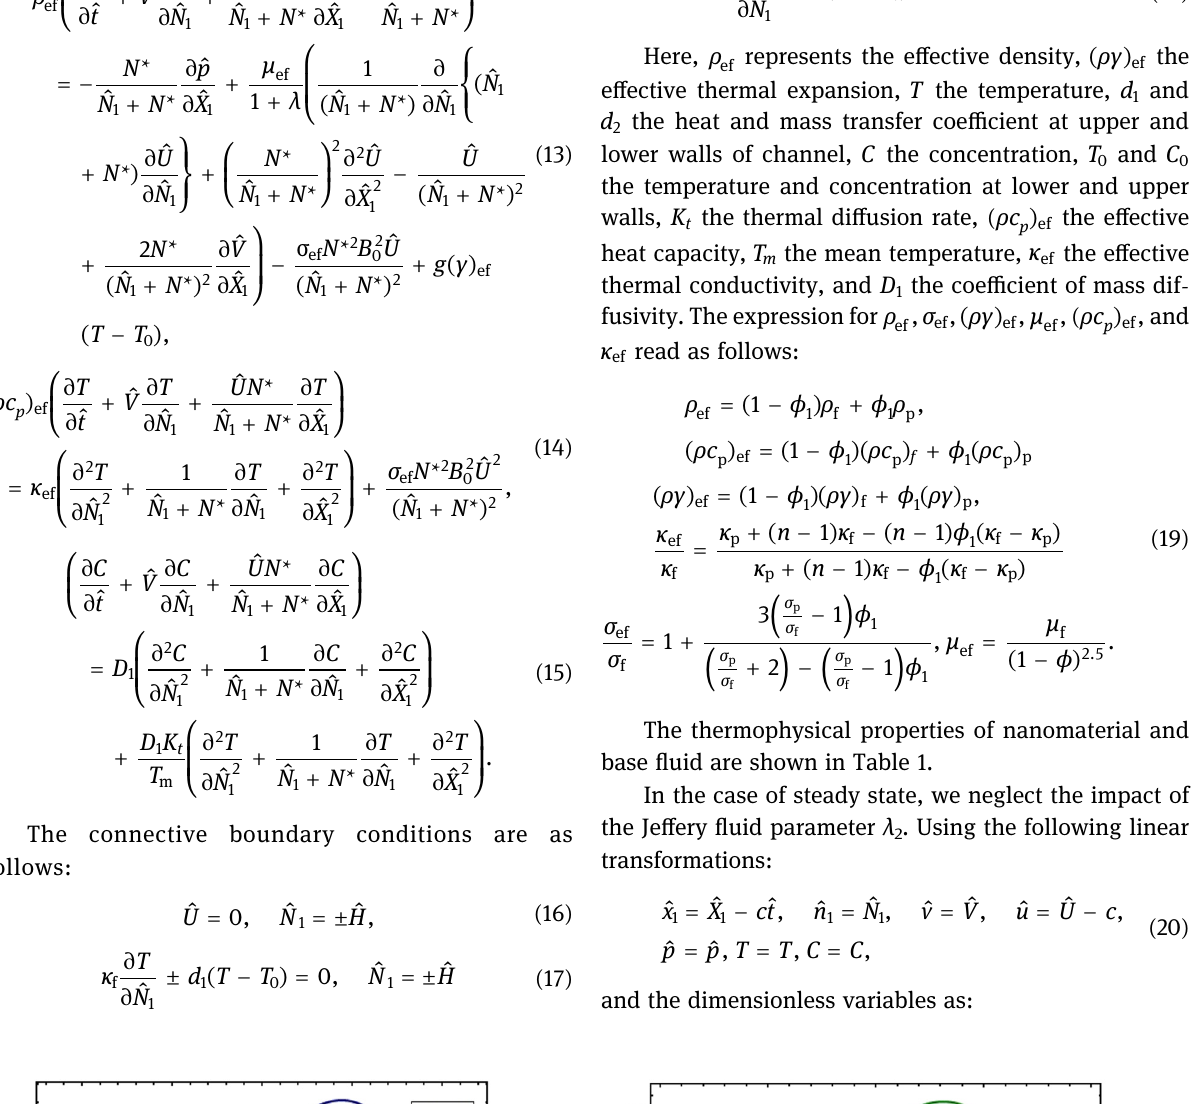
Figure 1: ( a and b ) Velocity pro fi le for λ 1 = 0.5, ϕ and B 0.2 2 =